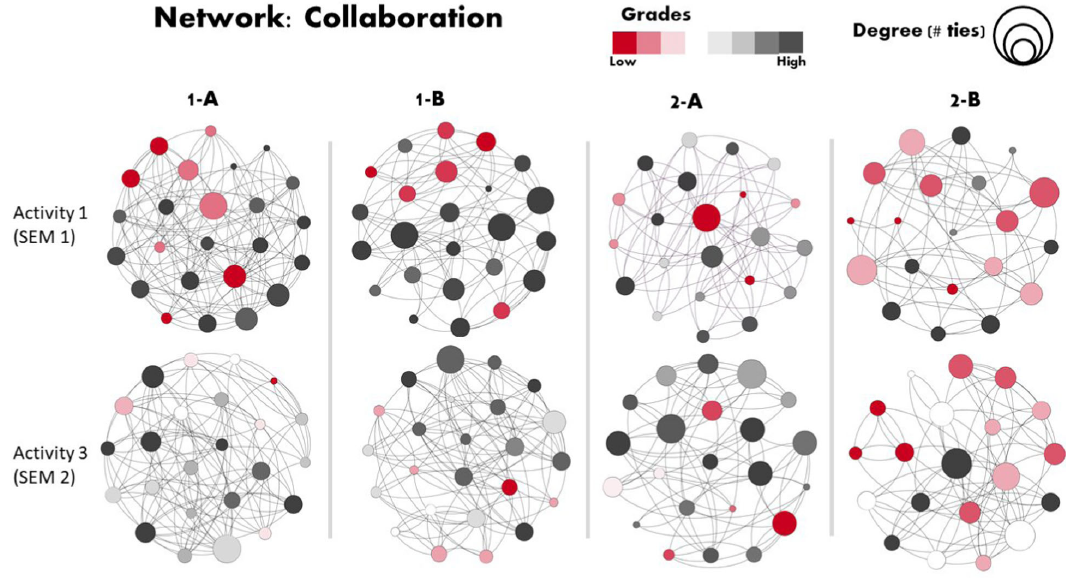
FIG. 4. Collaboration network on activities 1 (end of semester 1) and 3 (end of semester 2) for each class. Node color represents academic performance from low (red) to high grades (black); size of nodes indicates degree centrality — number of collaborative